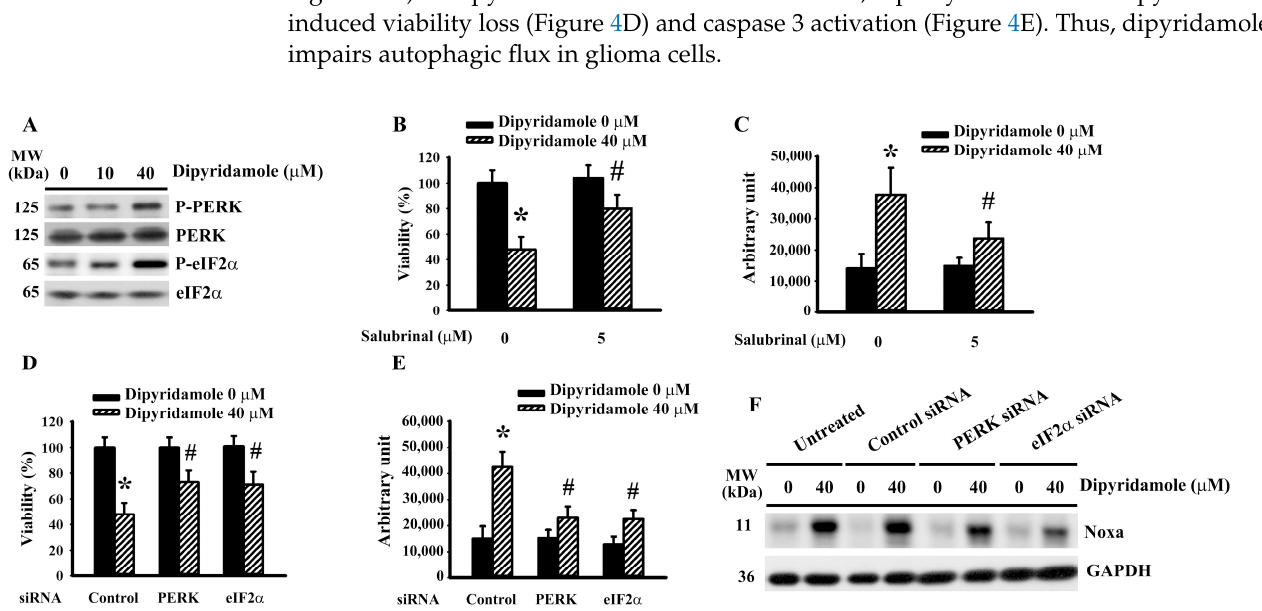
Figure 3. Dipyridamole induced ER stress in U87 cells. ( A ) U87 cells were treated with various concentrations of dipyridamole, as indicated for 12 h. Proteins were determined using western blotting with indicated antibodies. Representative blots are shown. U87 cells were treated with dipyridamole (0 and 40 µ M) in the presence or absence of salubrinal (5 µ M). ( B ) Cell viability (24 h) was determined using an MTS reduction assay. ( C ) Caspase 3 activity (12 h) was measured using an enzymatic assay. U87 cells were transfected with control siRNA, PERK siRNA, and eIF2 α siRNA for 24 h. The resultant transfected cells were treated with dipyridamole (0 and 40 μ M). ( D ) Cell viability (24 h) was determined using MTS reduction assay. ( E ) Caspase 3 activity (12 h) was measured using an enzymatic assay. ( F ) Proteins (12 h) were determined using western blotting with indicated antibodies. Representative blots are shown. * p < 0.05 vs. untreated control and # p < 0.05 vs. dipyridamole (40 μ M) control, n = 4.